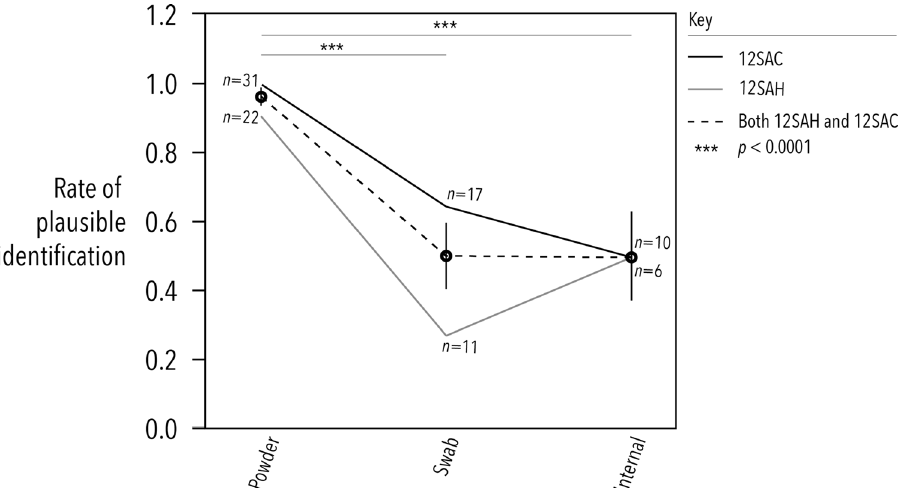
Figure 2. The rate of plausible molecular identifications for each barcode by extract type for the most abundant read sequenced. The criteria for assigning a molecular identity are detailed in SI 1.5. Note that sample sizes